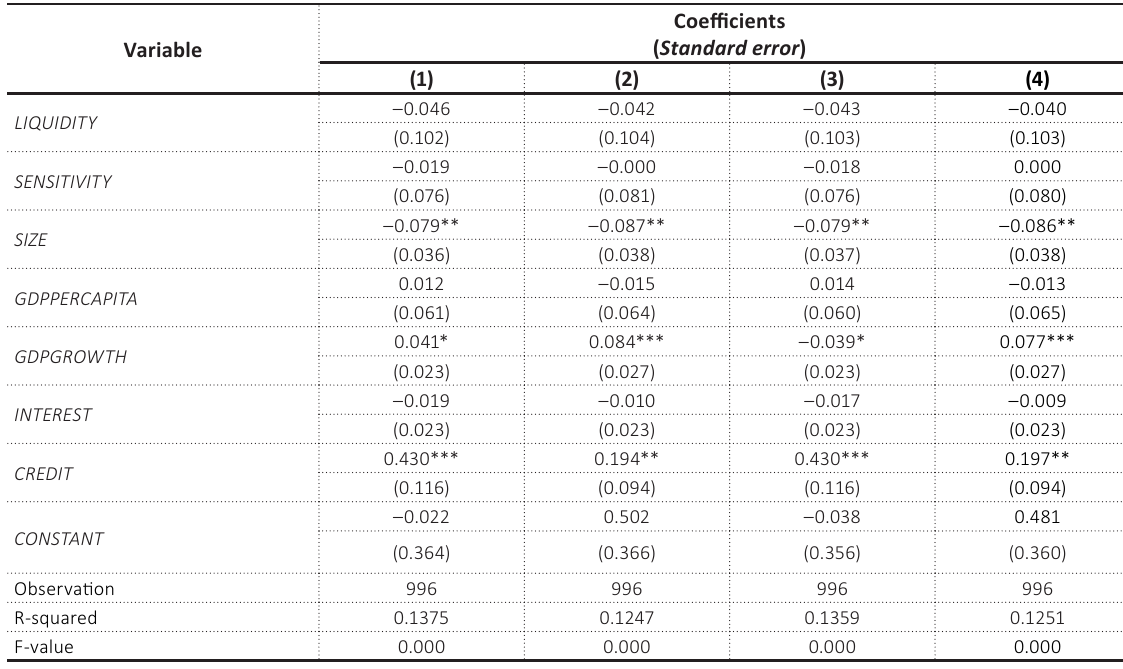
Table 3 (cont.). Regression